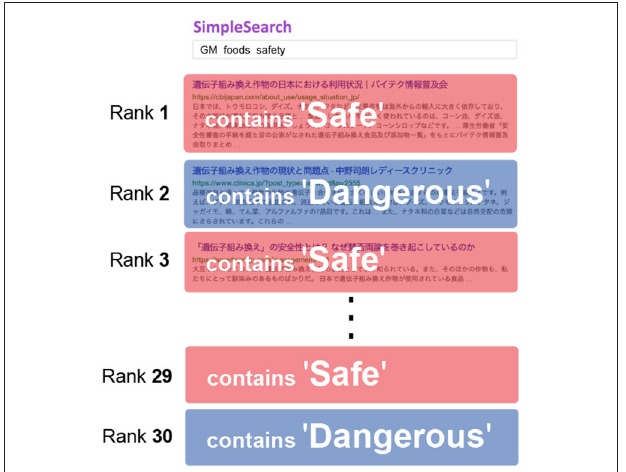
FIGURE 2 | Allocation of search results on SERP. Red and blue search results contain the terms “safe” and “dangerous” in their title or summary, respectively.